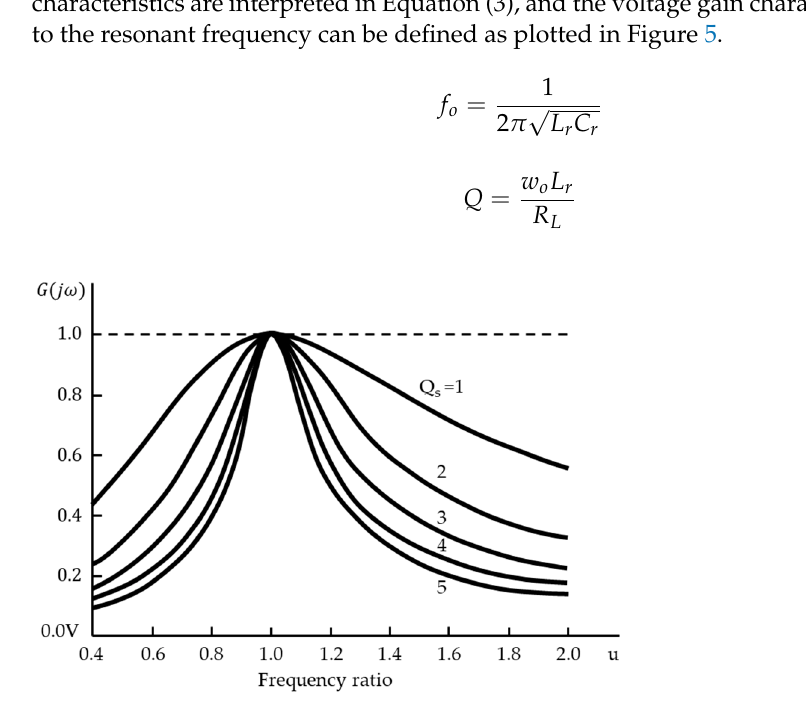
Figure 4. Series resonant circuit.